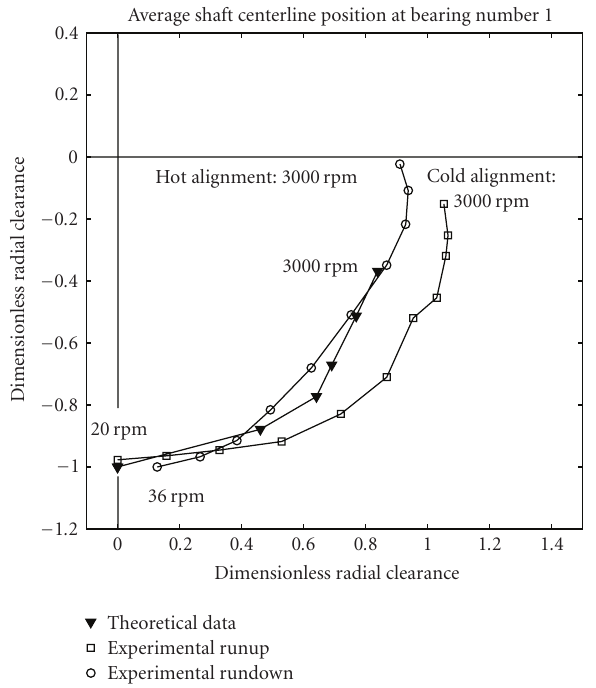
Figure 10: Average journal centreline curve at bearing no. 1: numerical results and experimental data measured in cold and hot thermal states (startup and rundown).